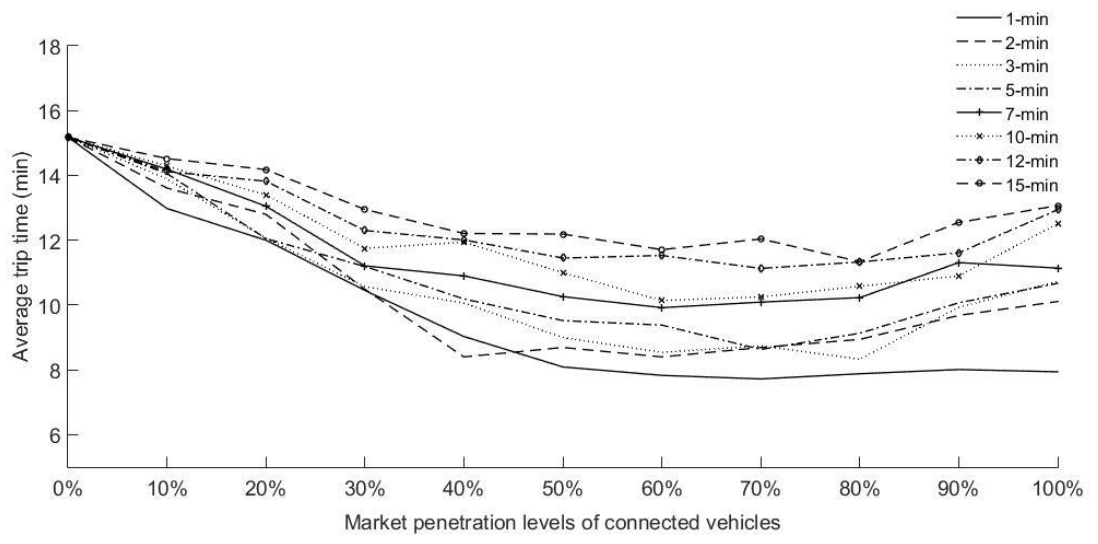
Figure 5. ATT for different updating intervals on varying the market penetration